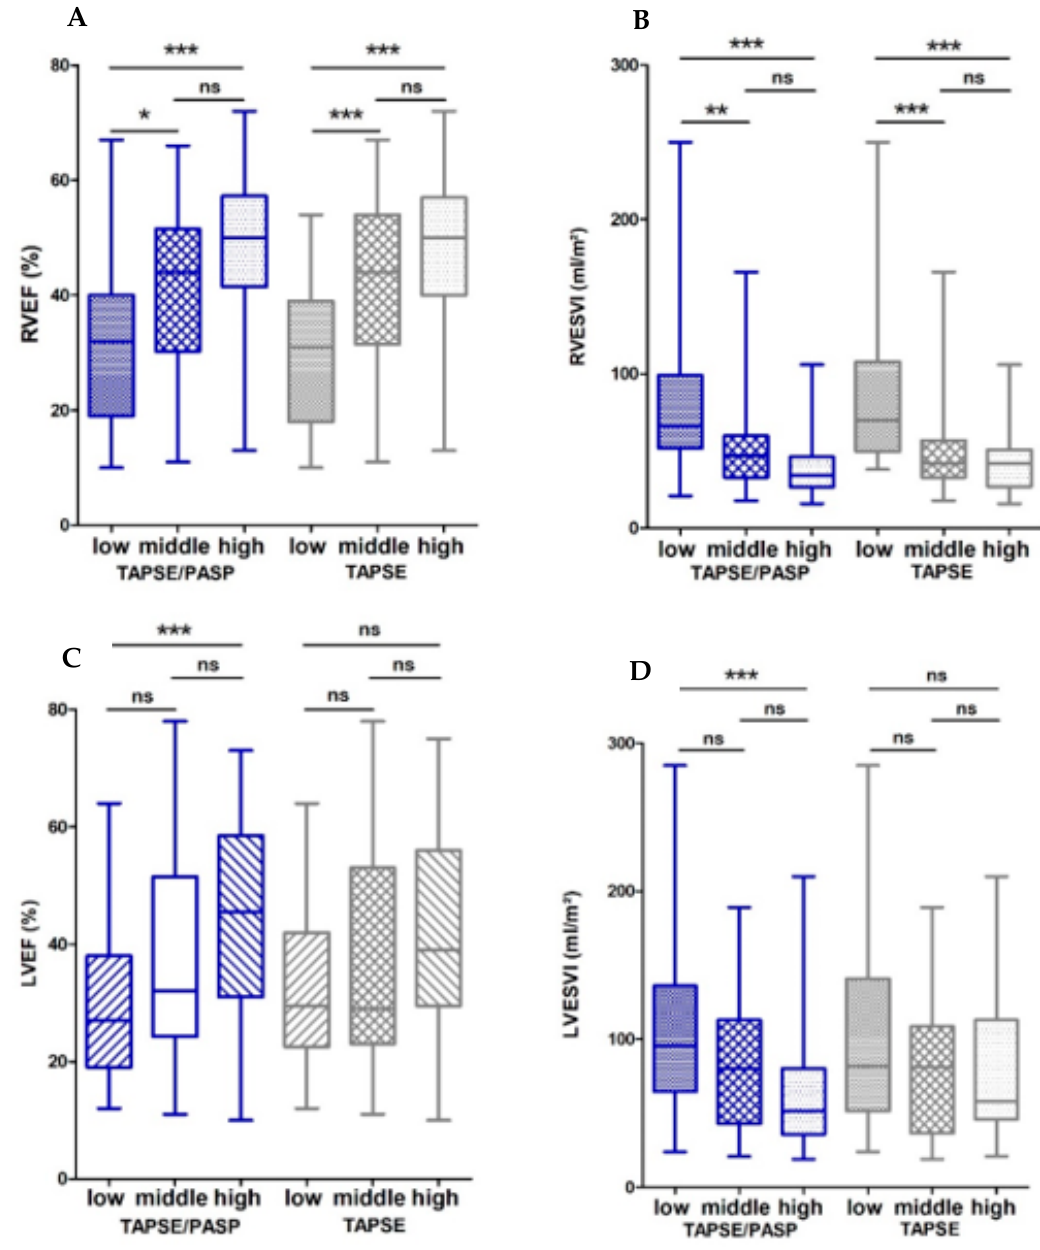
Figure 1. Box plots showing CMR characteristics of TAPSE/PASP and TAPSE tertiles. Shown are values for ( A ) RVEF, ( B ) RVESVI, ( C ) LVEF and ( D ) LVESVI divided according to TAPSE/PASP and TAPSE tertiles. Boxes represent median with IQR. ns, not significant, * p < 0.05, ** p < 0.01, *** p < 0.001.